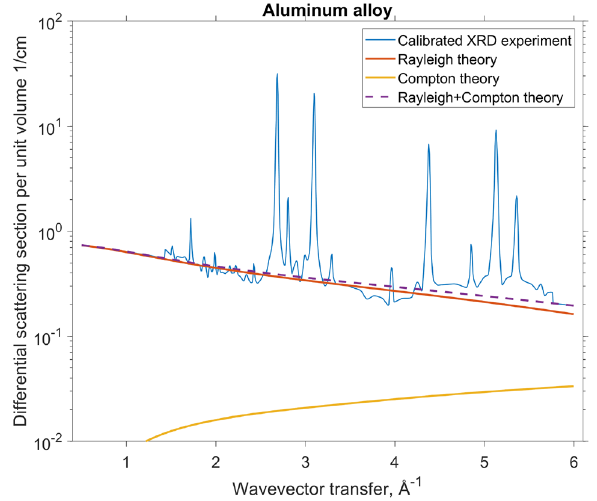
Figure 6. Experimental XRD pattern of an aluminum alloy 32 , rescaled by us to an absolute scale of cm − 1 to roughly match the theoretical, non-diffracting scattering, composed of Compton and Rayleigh terms. If experimental XRD data does not fully cover our desired range of 0.5–6Å − 1 , we use the theoretical data for a non-diffracting material of the same